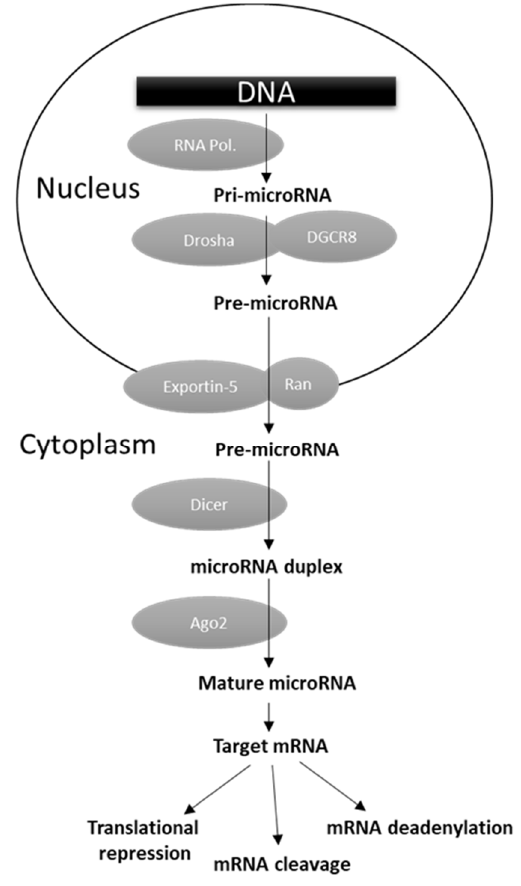
Figure 1. miRNA biogenesis and function.